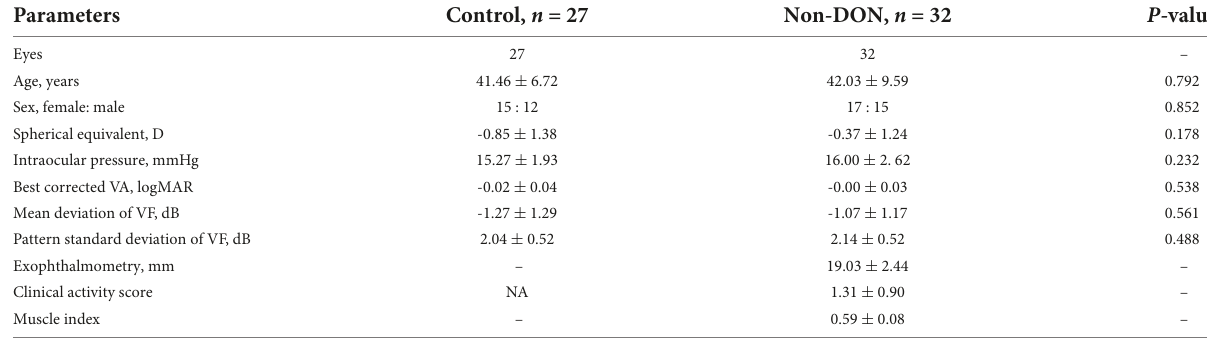
TABLE 1 Demographic and clinical characteristics of all